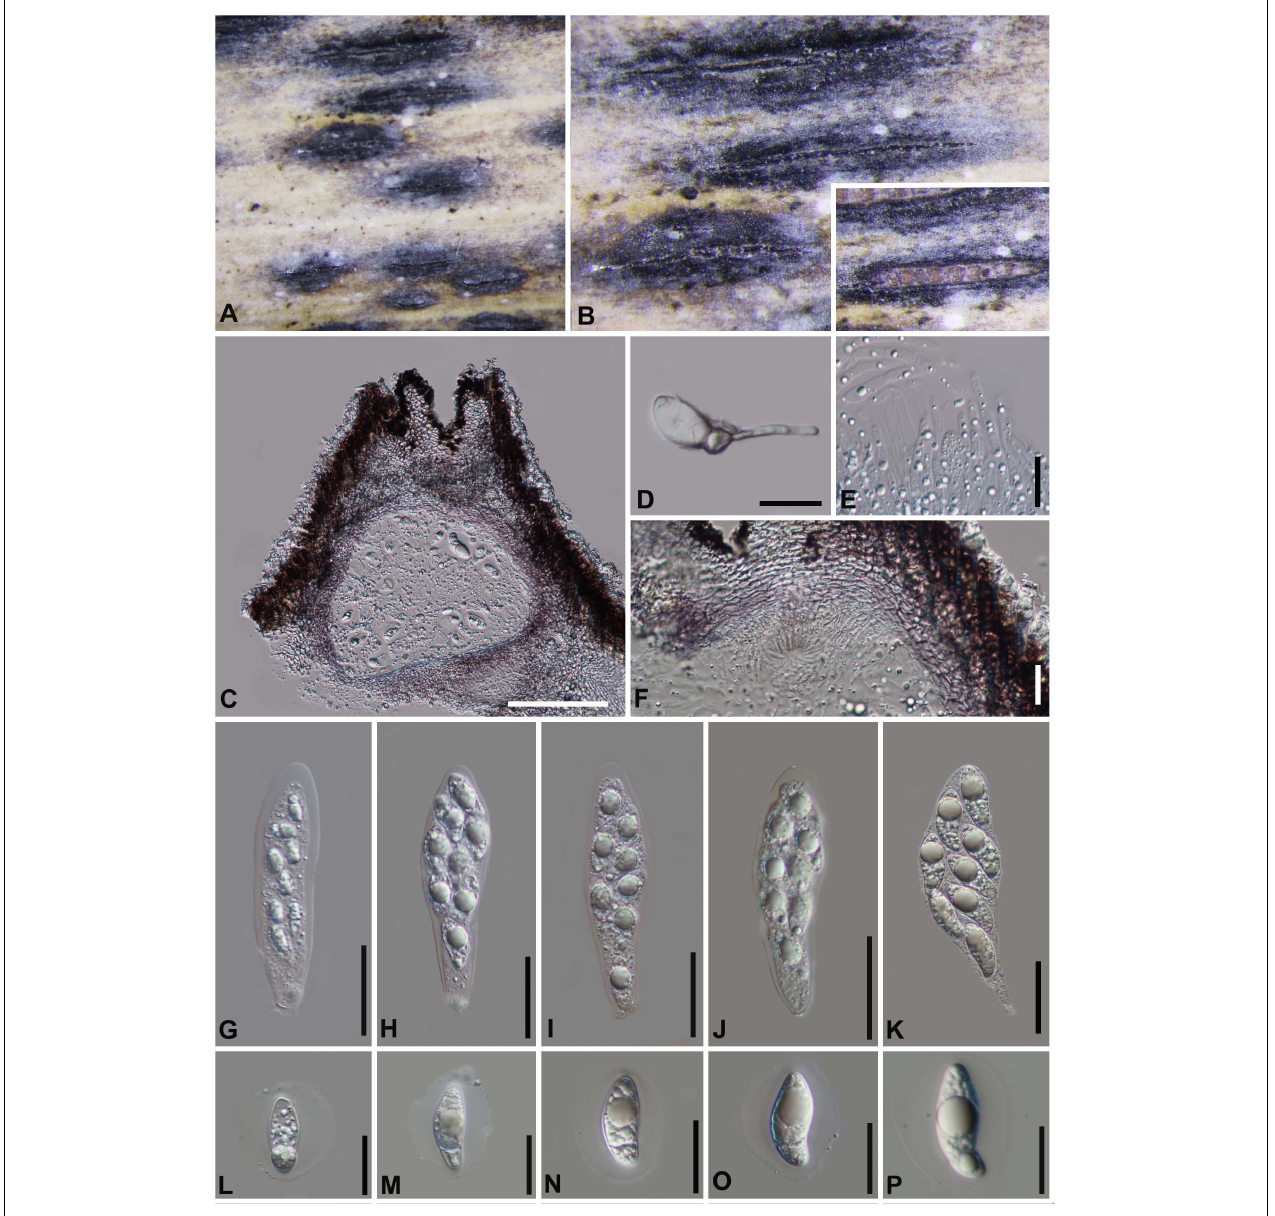
FIGURE 12 | Arthrinium neosubglobosa (GZAAS 20–0099). (A,B) Appearance of stromata on bamboo host. (C) Vertical section of stroma. (D) Germinating ascospore. (E) Paraphyses. (F) Peridium. (G–K) Asci. (L–P) Ascospore. Scale bars: (C) = 100 µ m. (D–F) = 20 µ m. (G–K) = 30 µ m. (L–P) = 20 µ m.